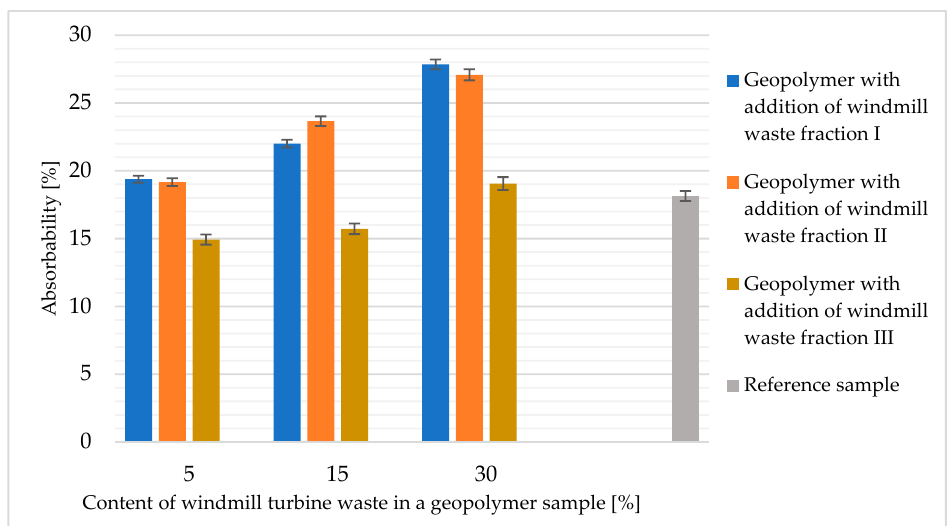
Figure 16. Absorbability of geopolymer samples based on fly ash and sand with the addition of waste from windmill turbines.